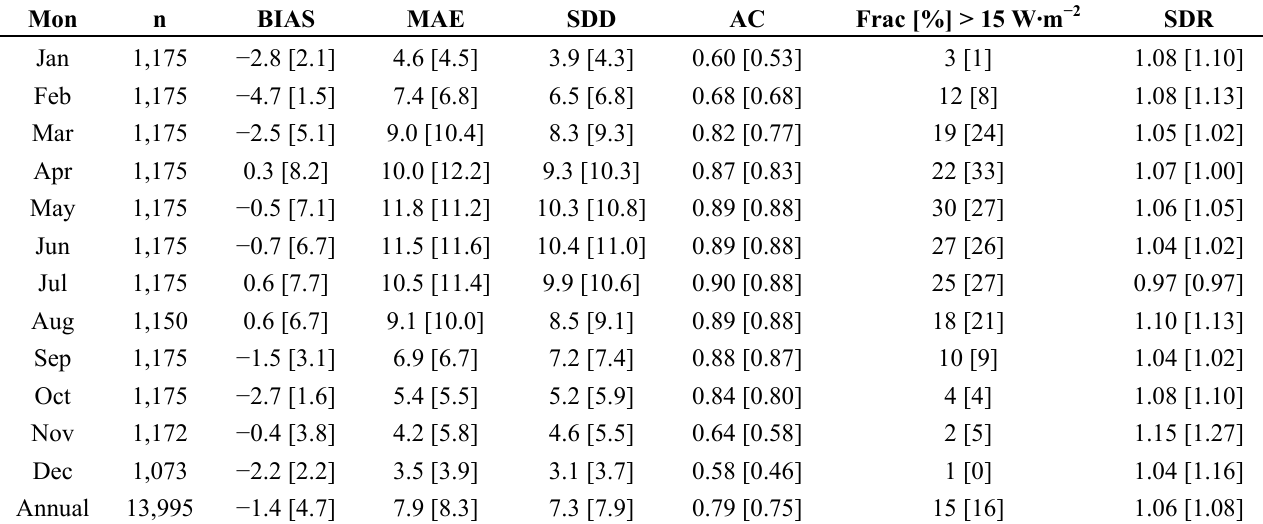
Table 5. Comparison of monthly SIS between the extended CM SAF series corrected using regression-based estimations of the station-wise derived mean-shifts and GEBA for the period 1983–2007 (results for the original series in brackets). Anomalies refer to the period